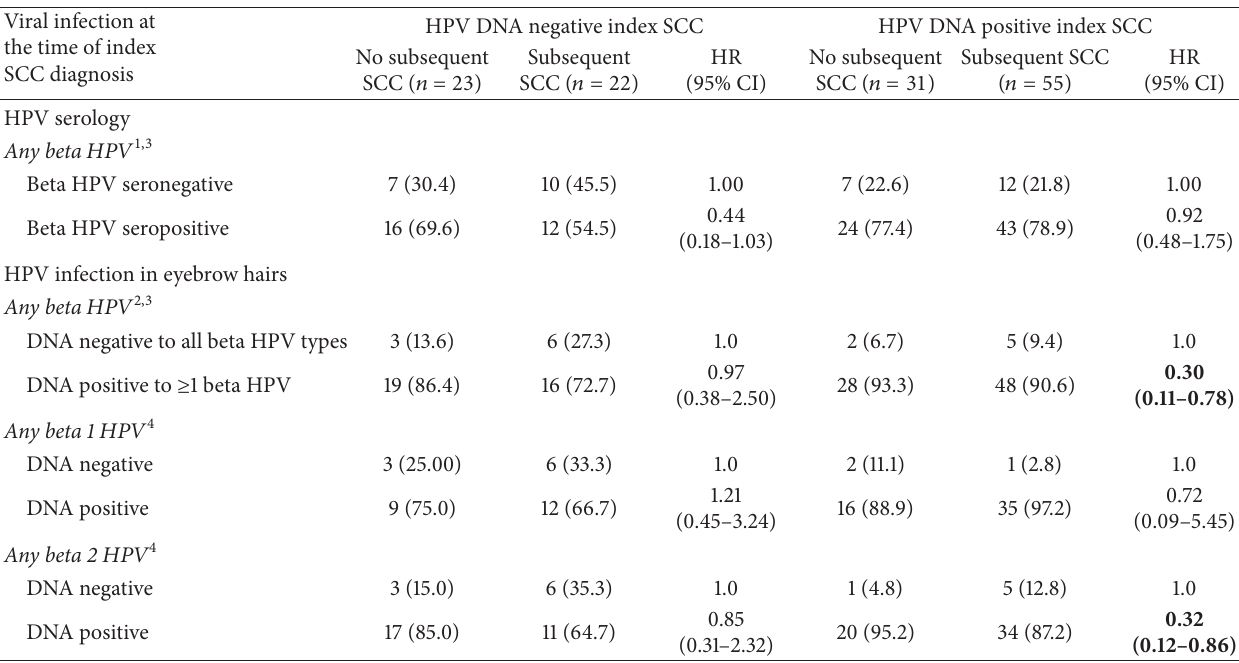
Table 5: Association of beta HPV infection in eyebrow hair and beta HPV seropositivity with the risk of subsequent SCC by index tumor HPV DNA status